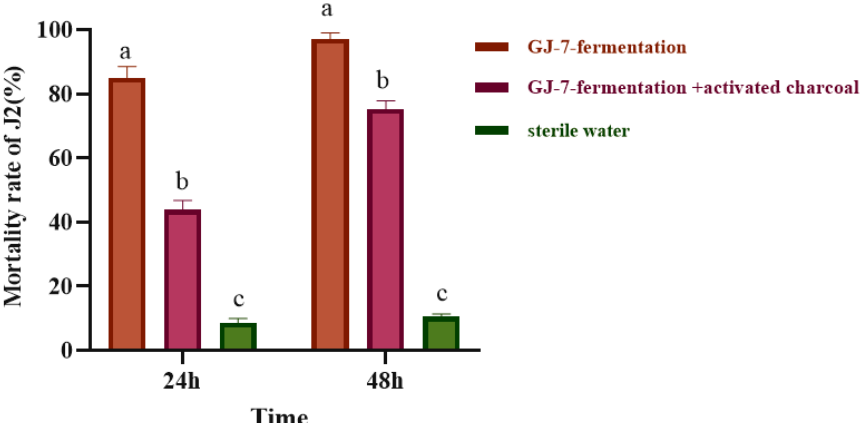
Figure 1. In vitro evaluation of the nematicidal activity of B. velezensis GJ-7 against M. hapla in a three-compartment Petri dish. Different lowercase letters indicate significant differences among treatments ( p < 0.05); bars indicate the standard error of the means ( n =